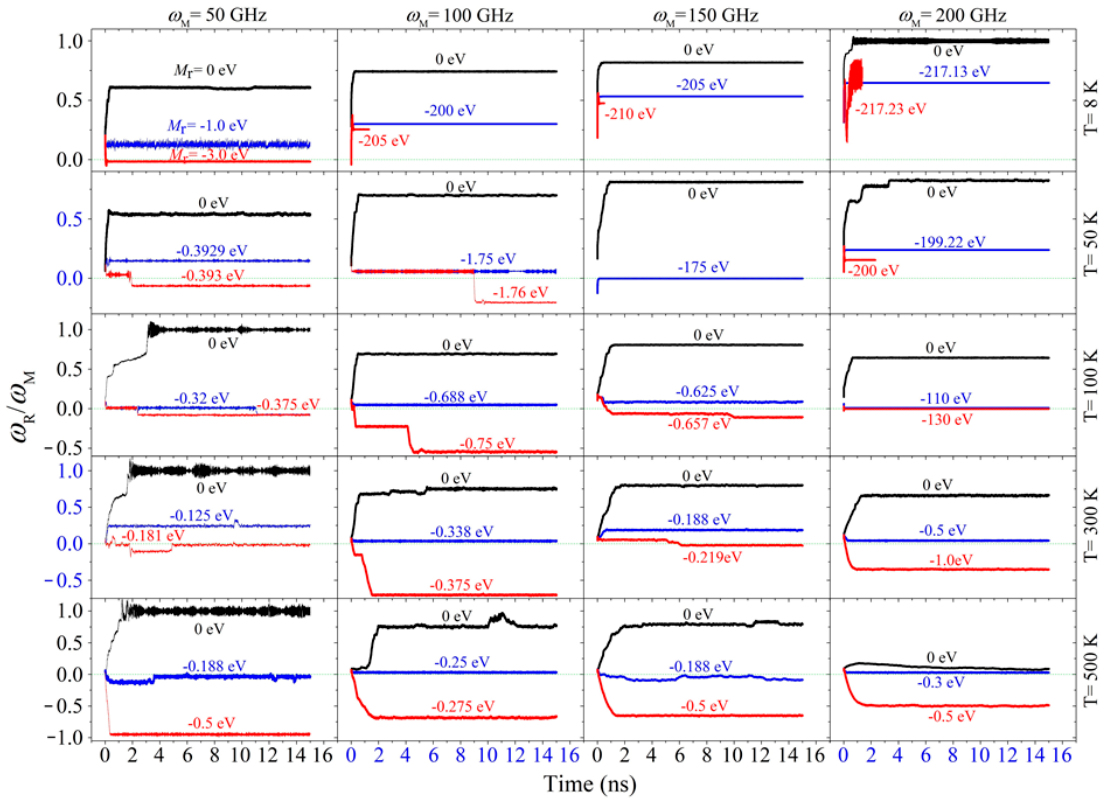
Figure 1. Historical curves of the rotation transmission ratio, i.e., R Tran in Equation (5), of the zigzag model with Gap = 1.5 nm and subjected to M r at different conditions. Note that the curves in each column are obtained at the same value of input rotation, e.g., “ ω M = 50 GHz” means that the curves in the left column are corresponding to the system with input rotational frequency of 50 GHz. Each row contains the curves obtained at the same temperature, e.g., “T = 8 K” says the curves in the top row are obtained at 8 K. Not all the results involved in the bi-section algorithm were shown here. Only three of them in each case were listed for showing the critical values.